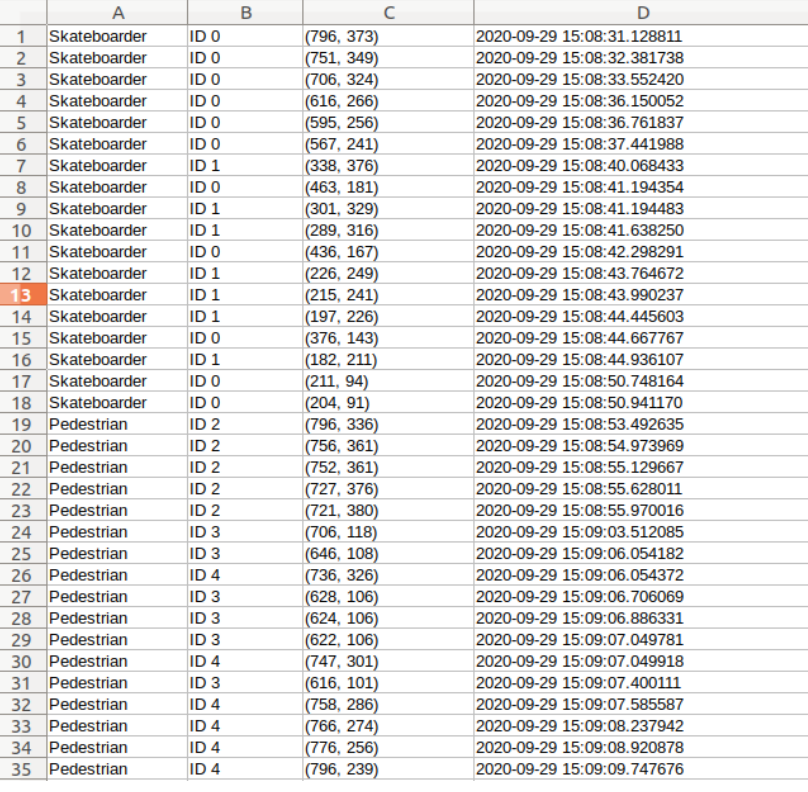
Figure 28. Data recorded on an Excel